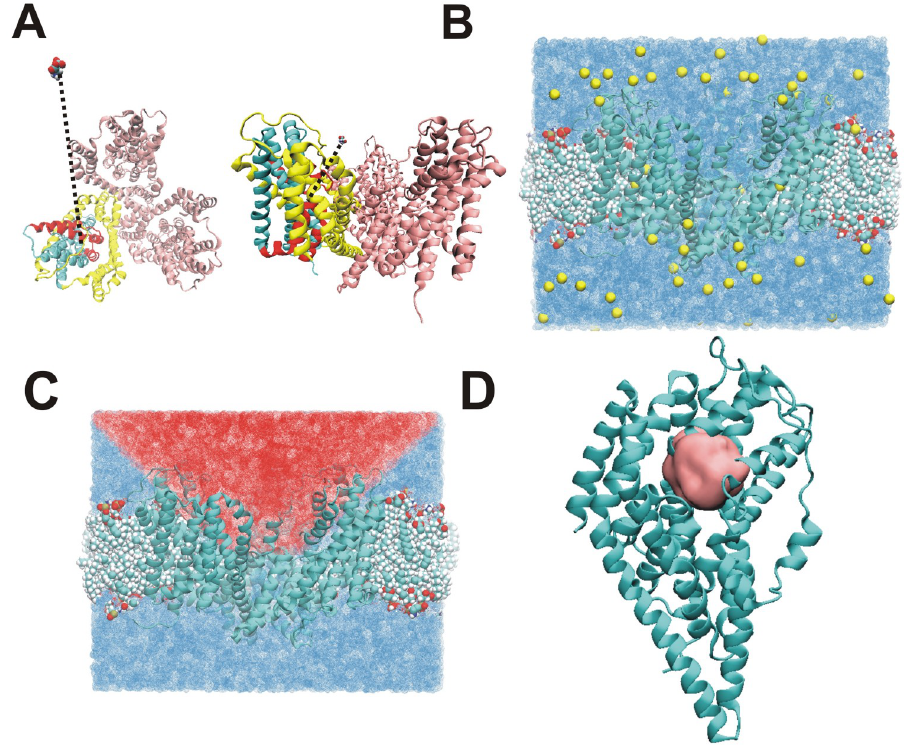
Fig 1. Simulation environment and region of force application. The initial structure of the transporter in the simulation displayed as top-view and side-view are shown in (A). A typical initial position of the aspartate molecule and its relative distance to the binding site is illustrated by the dashed line. (B) Setup of the simulation environment, Glt ph structure (2nwx) with three subunits (cyan). Only Na1- and Na3-bound state were used to insert into the lipid bilayer (drawn in VDW representation) and the simulation environment was generated and illustrated in (B). The yellow spheres indicate sodium ions at 0.15 M concentration. The blue color in the background shows water molecular drawn using solvent visualization in VMD. Lipids are shown in VDW mode and all pictures were generated using VMD. We used x 2 +y 2 < (z+15) and z > 0 Å to define the selection region (red) for external force application. The selection region is illustrated in a side-view (C). (D) Force cut-off region (pink) within 7 Å of reference atom (Arg-397, CZ). Details of region selection are outlined in Materials and Methods